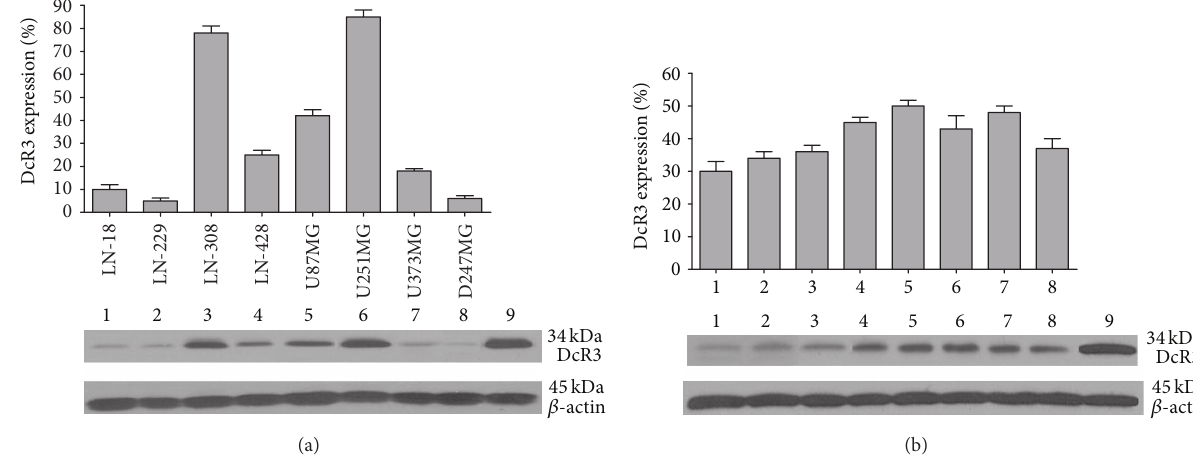
Figure 4: Expression of DcR3 in glioma cells. (a) Supernatants of 8 human long-term glioma cell lines were subjected to western blot; 1: LN-18, 2: LN-229, 3: LN-308, 4: LN-428, 5: U87MG, 6: U251MG, 7: U373G, 8: D247MG, and 9: cell lysis sample from known DcR3 positive